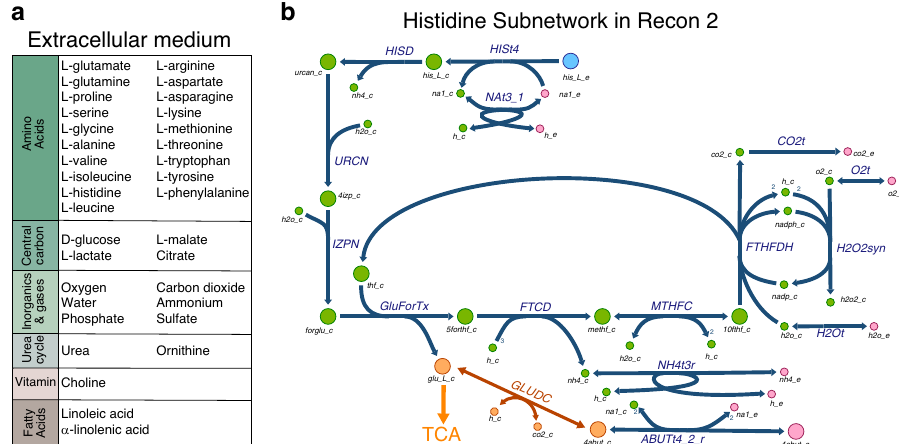
Fig. 3 Extracellular medium utilization. a Extracellular medium composition de fi ned in the models. b Graph of the subnetwork from Recon 2 for the uptake of L -histidine and the medium components required for its metabolism. Green represents the metabolites from the subnetwork, and orange represents the metabolites of the core network where the subnetwork is connected. In blue, the medium metabolite under study ( L -histidine) and in pink, the extracellular metabolites co-utilized to metabolize L -histidine. The pathway starts with the transport of L -histidine from the extracellular space to the cytosol, where it is sequentially transformed into urocanate (urcan_c), 4-imidazolone-5-propanoate (4izp_c), N-formimidoyl- L -glutamate (forglu_c), L -glutamate (glu_L_c),